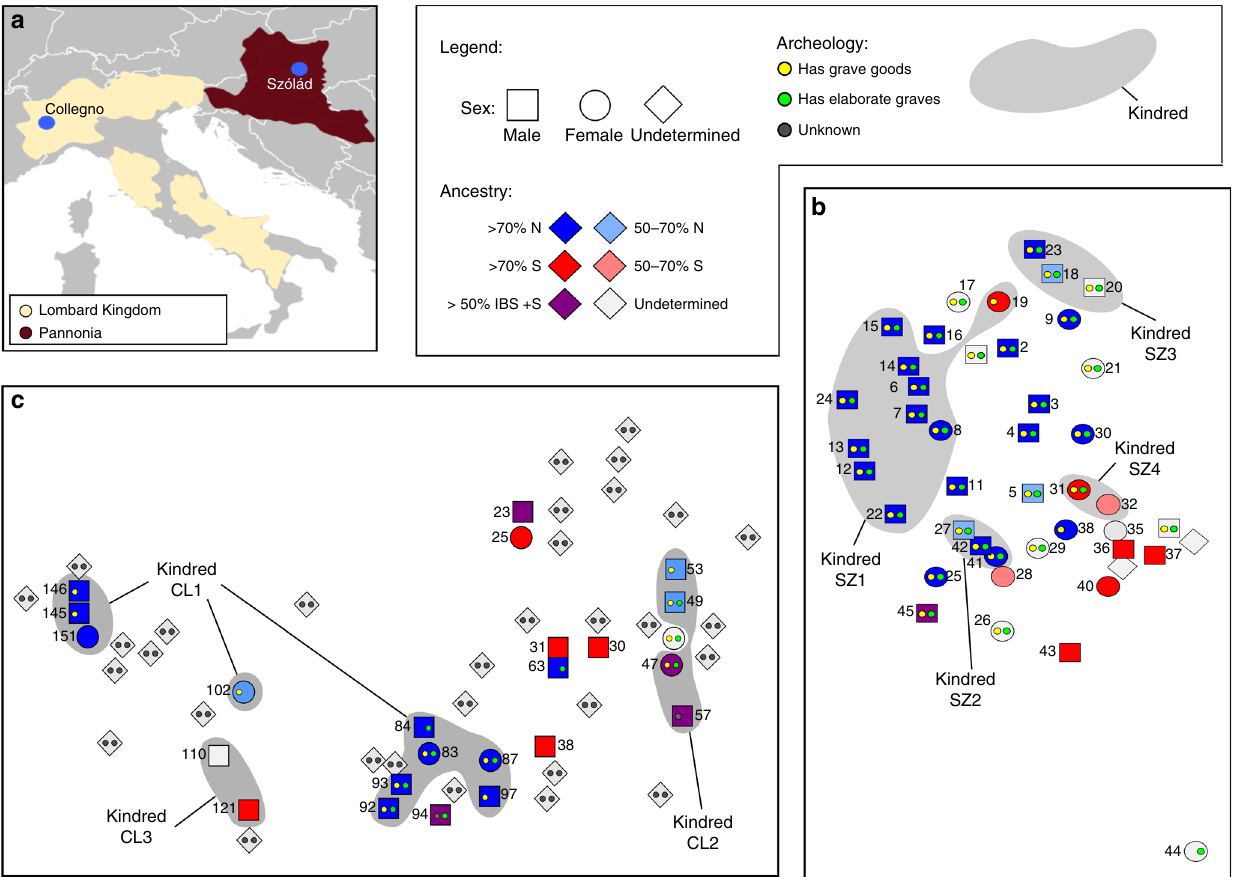
Fig. 1 Archeological and genetic characterization of Szólád and Collegno. a Map of Europe showing the location (blue dots) of the two cemeteries and regional context is included (the Roman province of Pannonia in burgundy and the Longobard Kingdom in beige). b , c Spatial distribution of graves in Szólád and Collegno ( fi rst period burials only) with indication of sex (different shapes), genetic ancestry (different colors) and summary of archeology (yellow dots for presence/absence of grave furnishings and green dots for the presence of wooden elements in grave structure). Kindreds (in the biological sense) are indicated by gray shading in b and c . N = FIN + GBR + CEU, S = TSI. The map image in a is modi fi ed from the original Blank_map_of_Europe_ (with_disputed_regions).svg (https://commons.wikimedia.org/wiki/File:Blank_map_of_Europe_(with_disputed_regions).svg) by maix